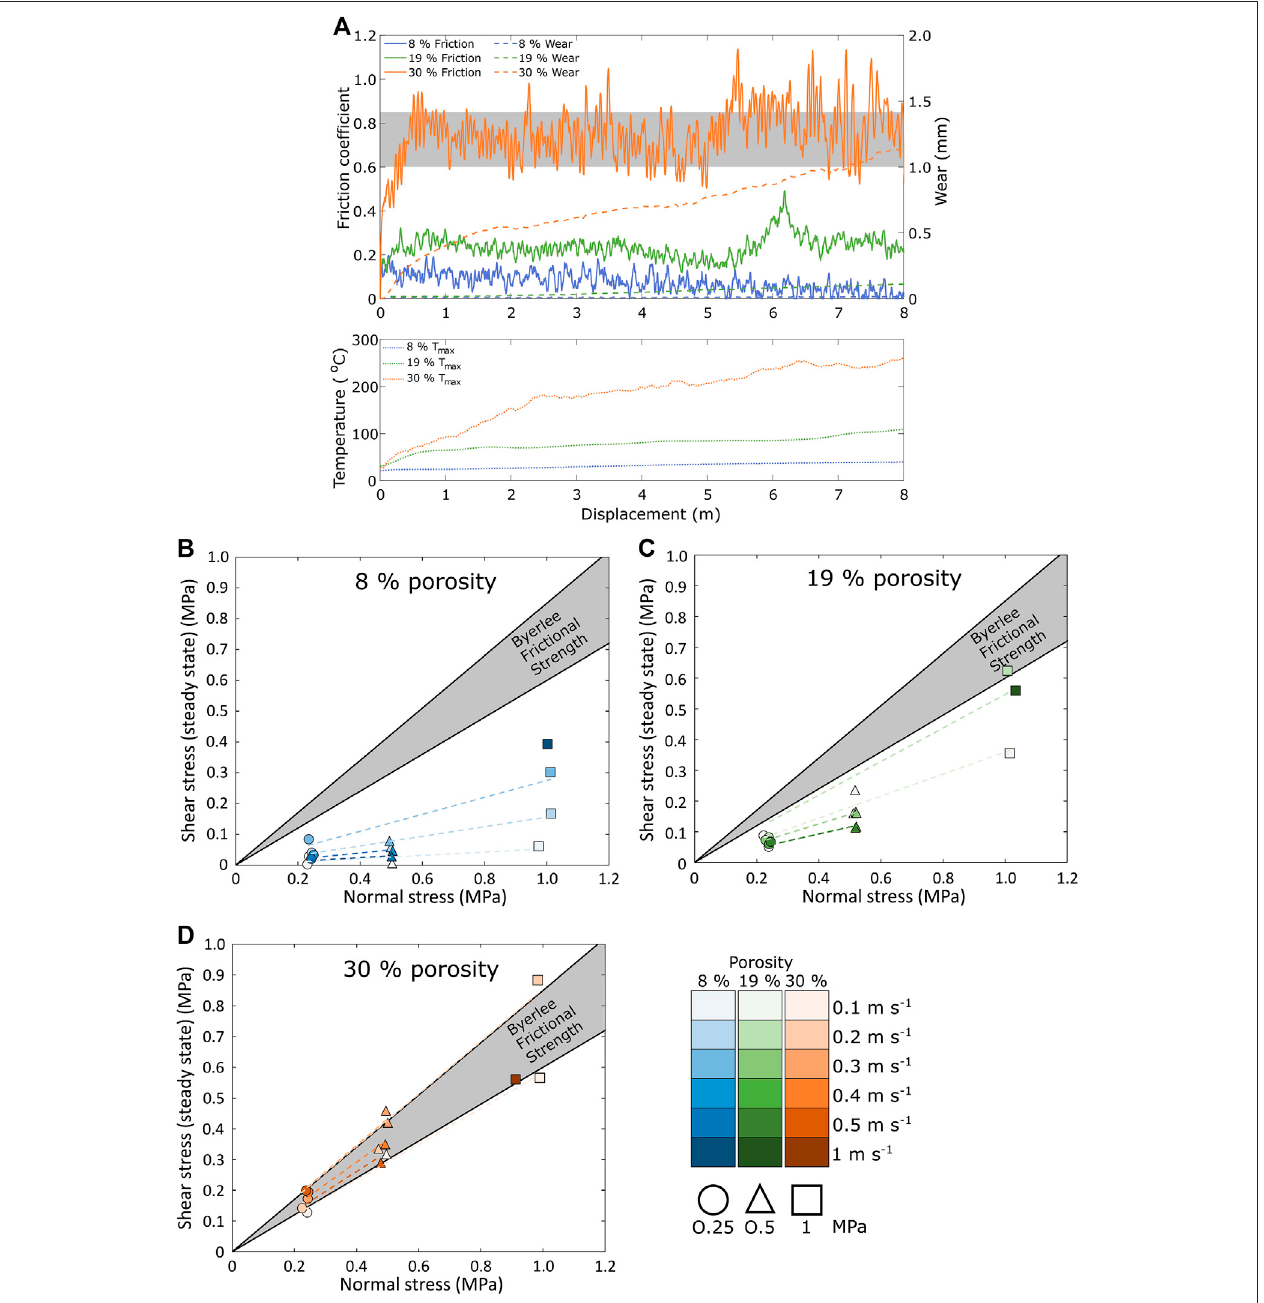
FIGURE1| Mechanicaldataforglassanalogueswithdifferentporosities. (A) Exampleevolutionoffrictioncoef fi cient,shortening(wear)andtemperatureforslipparameters 0.4 m s − 1 and 0.5 MPa for the suite of porosities tested (8% blue, 19% green and 30% orange). T max is the peak temperature measured by the thermographic camera in any givenframe.Noteinitiallyheightenedfrictioncoef fi cientsandfasterwearattheinitiationofslipandsubsequentreductiontosteadystateconditionsafterapproximately0.5 – 2.0 m of slip. (B – D) Average steady state shear stress ( τ ss ) plotted against normal stress for (B) 8%, (C) 19% and (D) 30% porosity — see Supplementary Table S1 for slip distances over which this was measured. The Byerlee friction range 0.6 – 0.85 is highlighted in grey for reference. Darker colour shades indicate increasing slip rate and shape indicates normal stress. The 30% porosity sample approximates Byerlee frictional behaviour, and with decreasing porosity the samples ’ response deviates further.